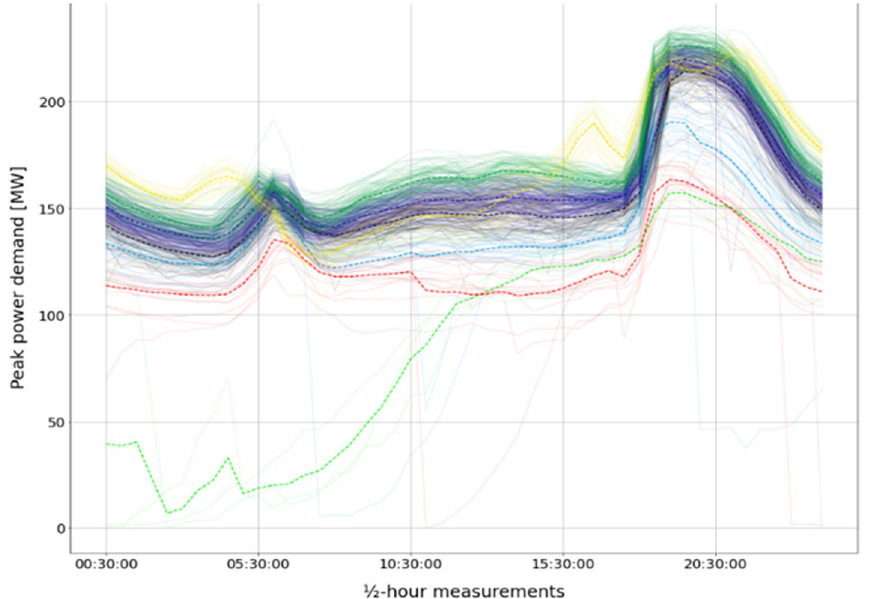
Fig. 23 Seven clusters for the daily load profiles in